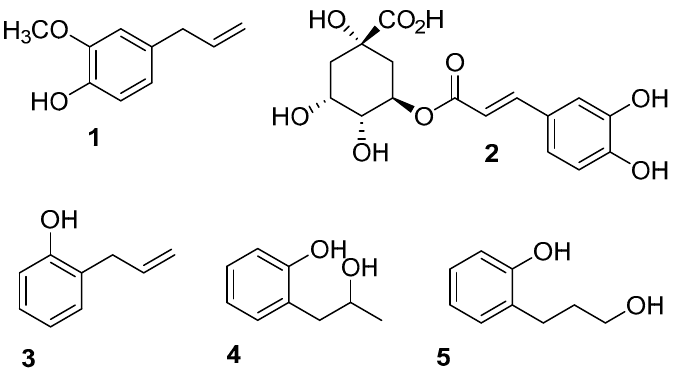
Figure 1. Chemical structure of natural phenylpropanoids: Eugenol ( 1 ), chlorogenic acid ( 2 ), 2-allylphenol ( 3 ), 2-(2-hydroxypropyl) phenol ( 4 ), and 2-(3-hydroxypropyl) phenol ( 5 ).